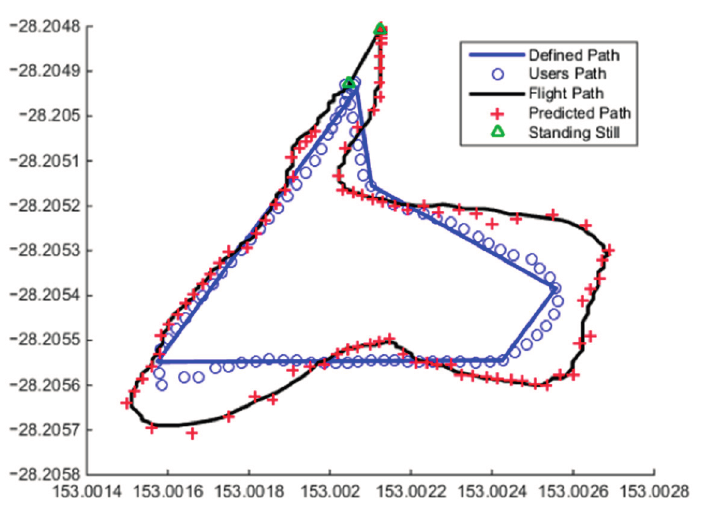
Figure 10. Resultant flight path, predicted waypoints, actual user path (noisy data) and the defined path demonstrating the capabilities of the system for states Ω